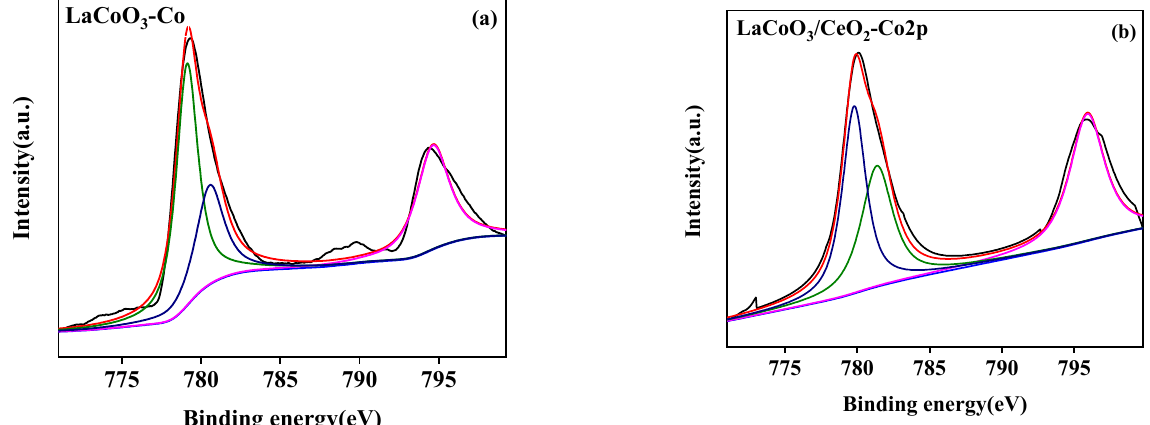
Figure 8. XPS spectra of Co 2p of LaCoO 3 ( a ) and LaCoO 3 /CeO 2 ( b ).